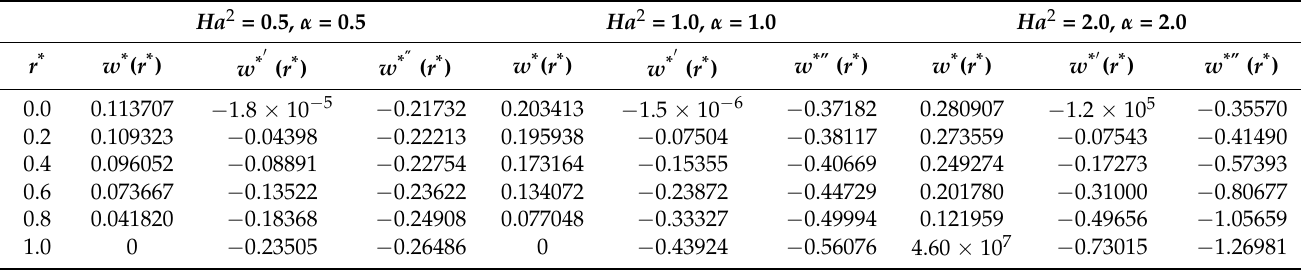
Figure 4. ( a – d ) Shows the plots of velocity profiles for variations in Ha 2 with different values of the nonlinearity parameter. Table 2. The values of w ∗ ( r ∗ ) , w ∗ (cid:48) ( r ∗ ) , and w ∗ (cid:48)(cid:48) ( r ∗ ) for different variations in the Hartmann electric number and nonlin- earity